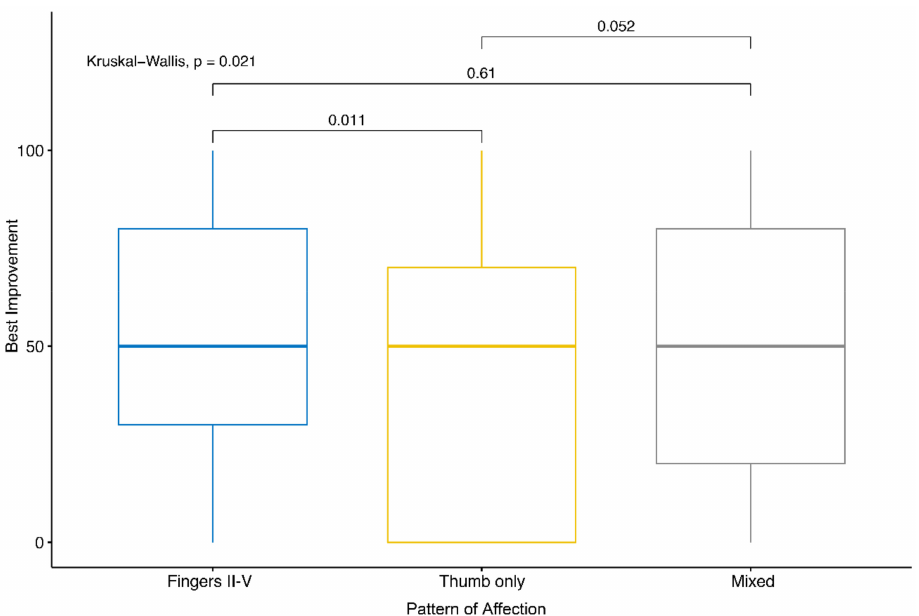
Figure 2. Therapeutic success in dependence of the pattern of a ff ection of the fingers. The Kruskal–Wallis Test was applied to compare and the best improvement of patients in dependence of the a ff ection pattern of the fingers. The patients were grouped according to the a ff ection pattern of the fingers: thumb only, fingers II–V without the thumb, or a mixed a ff ection pattern. Here, the best percentage of improvement achieved was applied for the test independent of the time point of data collection.